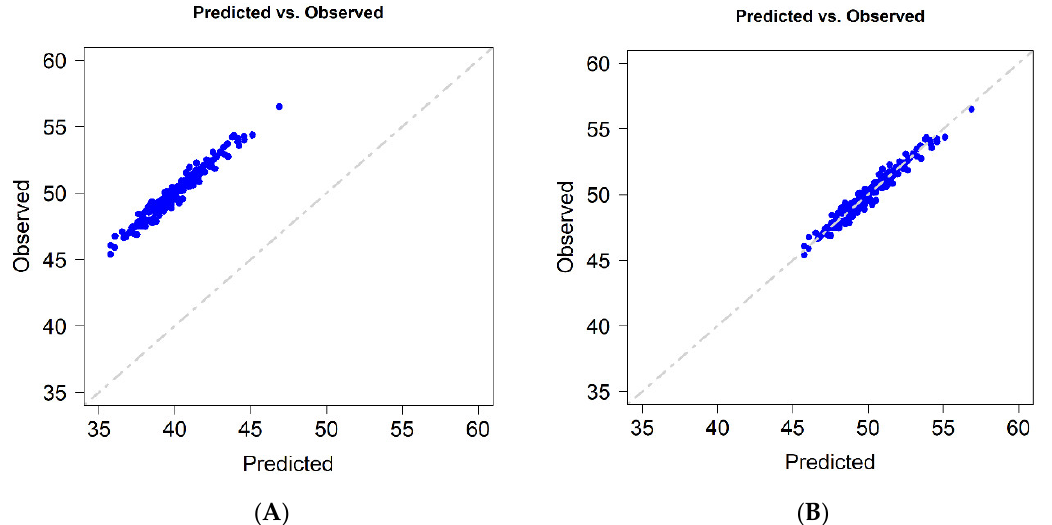
Figure 1. Graphical representation of the predicted and observed values using the conventional GP model ( A ) and the correction of these implicit biases in the values by a constant ( B ).